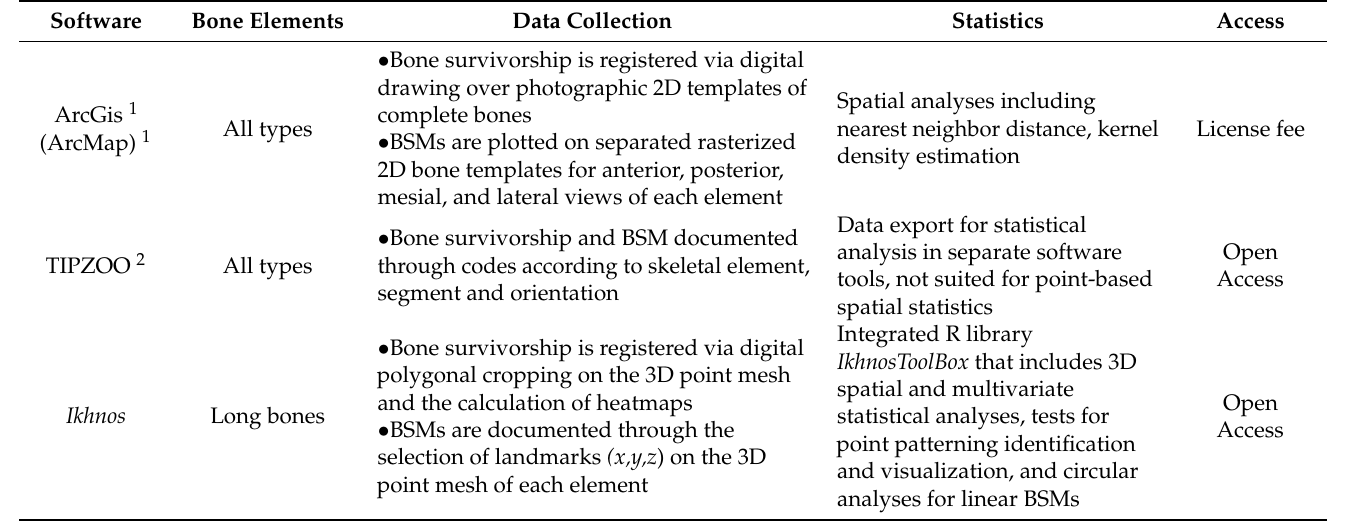
Table 1. Comparison of software packages designed for the registration and analysis of